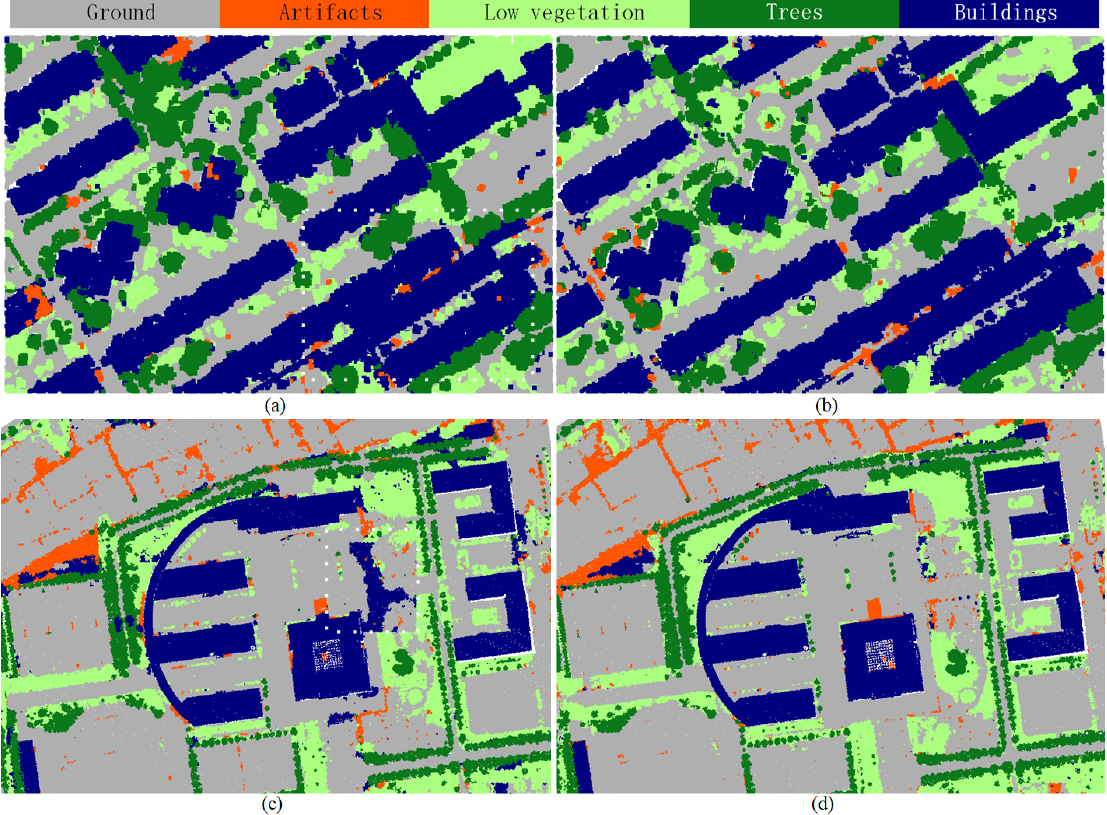
Figure 16. Details of classification results in dense building areas mixed with low vegetation and trees. ( a , c ) from PointNet++, ( b , d ) from